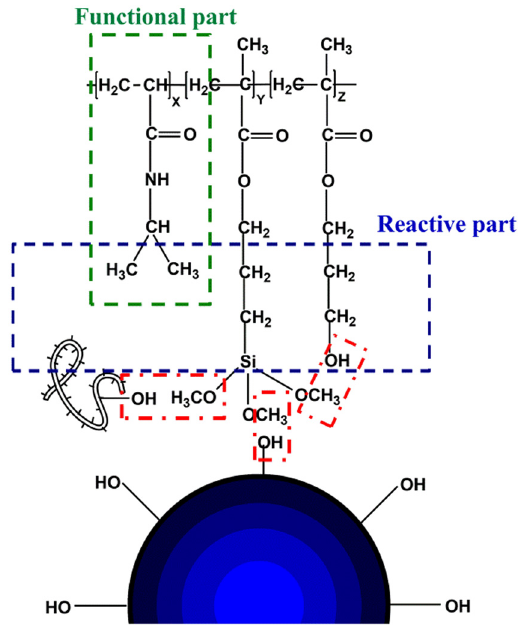
Figure 2: Molecular structure of PNIPAAm copolymer and covalent linkage between glass spheres and copolymers during the pre - paration of composite